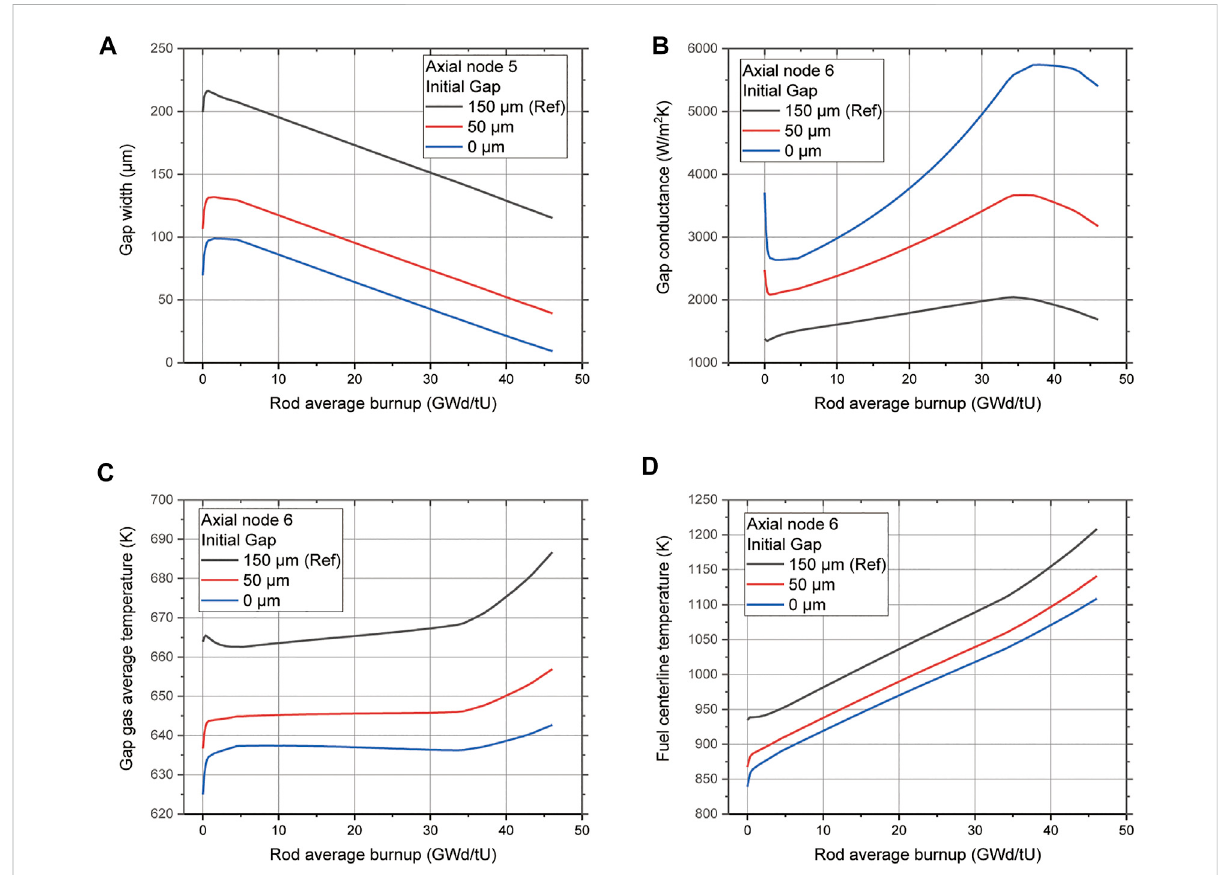
FIGURE 15 Initial gap size effects on (A) gap width, (B) gap conductance, (C) gap average temperature, and (D) fuel centerline